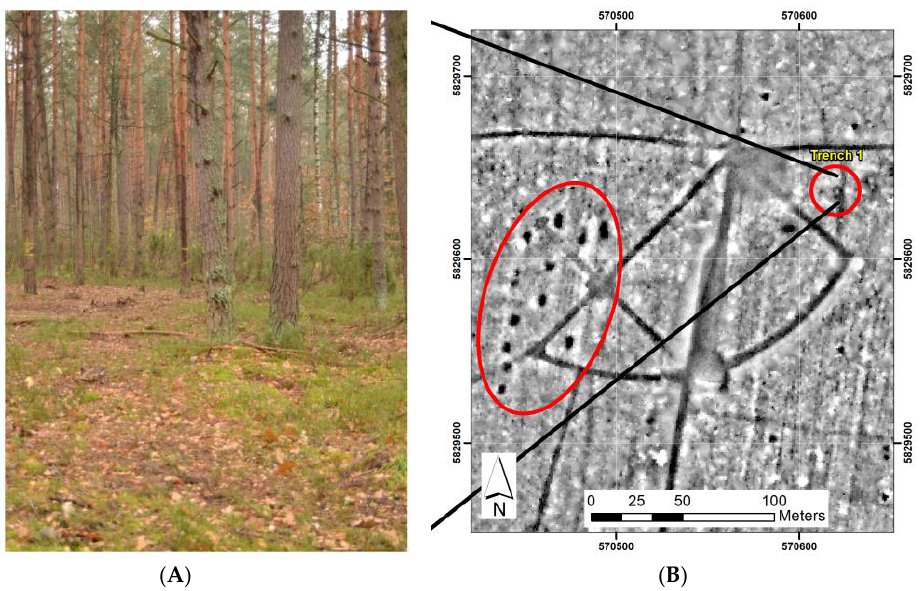
Figure 6. ( A ) Example of diverse vegetation; low and medium greenery in the vicinity of one of the pits, test dig 1. Area cleared of low vegetation; photo: R. Zapłata; ( B ) visualisation of airborne laser scanning (ALS) data (local relief model, radius: 10 pix.) with indicated cluster of known death pits (larger red ellipse) and an indicated site where archaeological excavation was conducted (smaller red